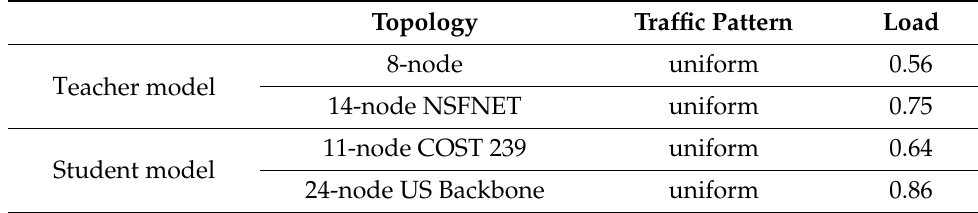
Table 4. Traffic loads for all traffic patterns in Section